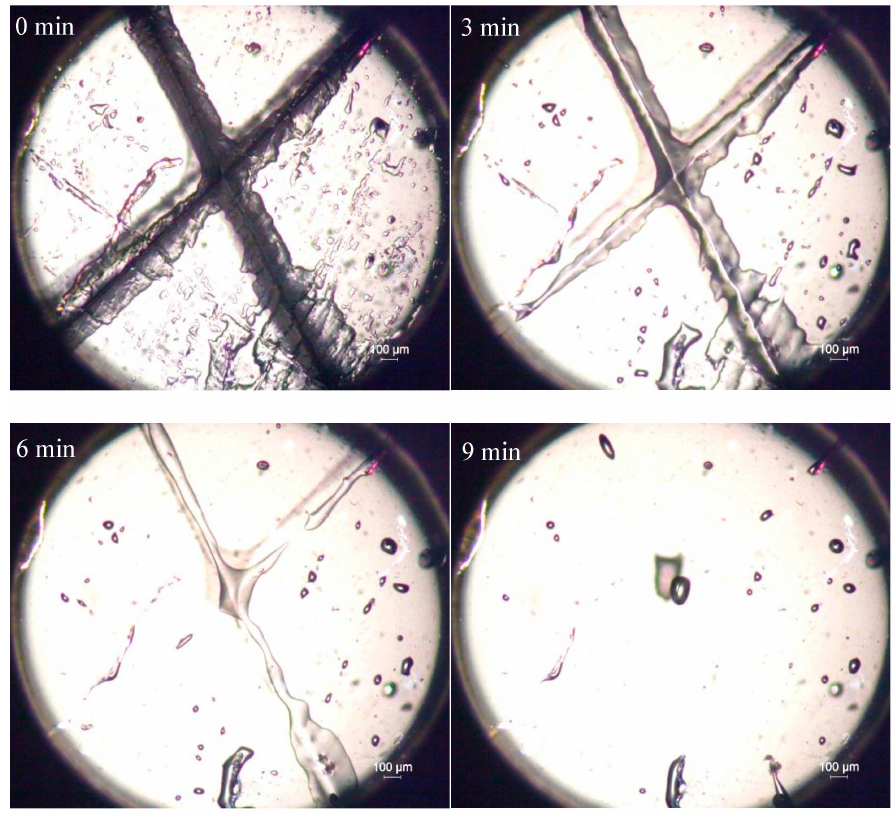
Figure 4. The healing process of PET-DA-PU film upon heat treatment at 100 ◦